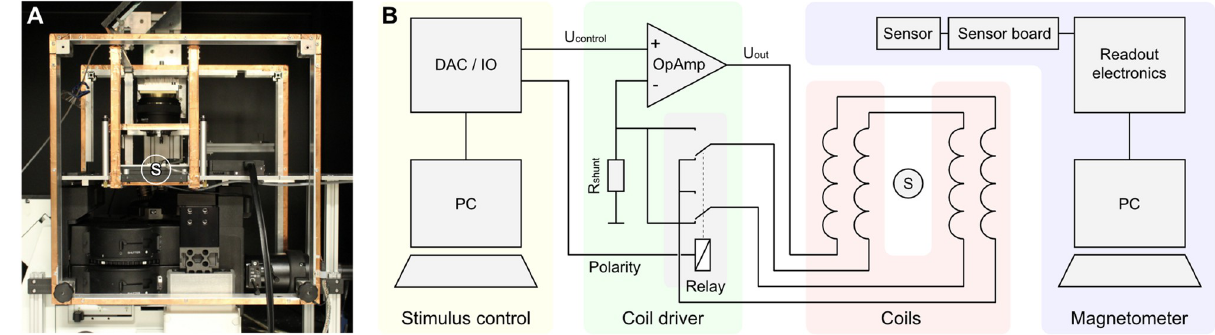
Fig 1. Electrophysiological setup with an integrated three-axis Helmholtz coil system. A: Extracellular multielectrode recording setup with integrated coils. B: Schematic overview of the setup components for the generation and measurement of magnetic field stimuli. Coil driver and coils are shown for one of three axes. The placement of the specimen is indicated by the letter S in A and